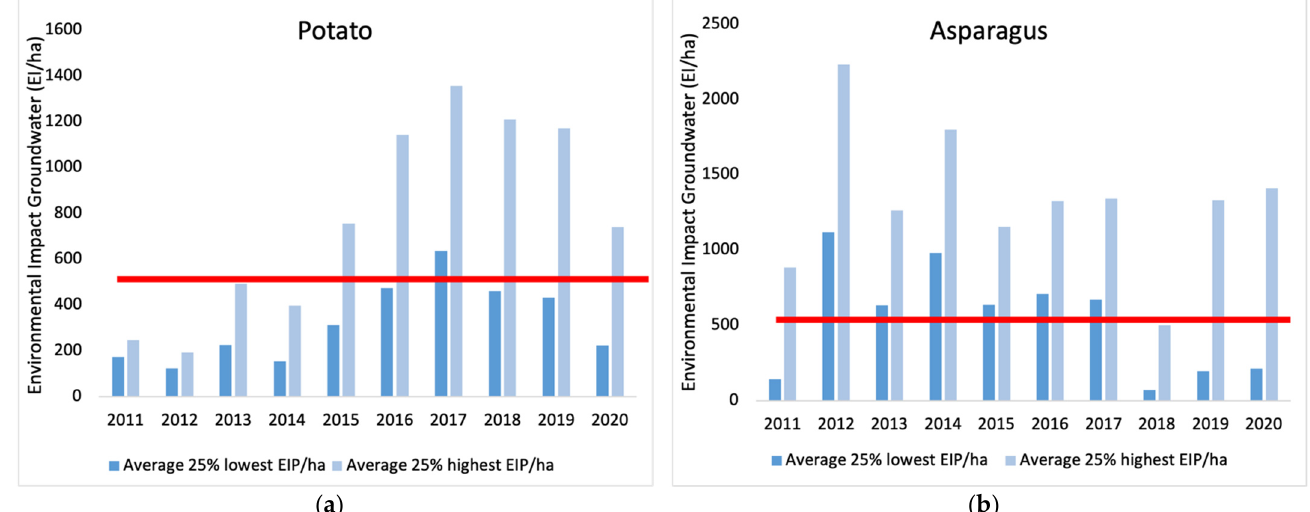
Figure 4. Environmental impact points (EIP/ha) for the 25% highest scoring farmers and 25% lowest scoring farmers for ( a ) potato and ( b ) asparagus. Figures include farmers in and out of the protection areas. The red line indicates the target value of 500 EIP/ha.